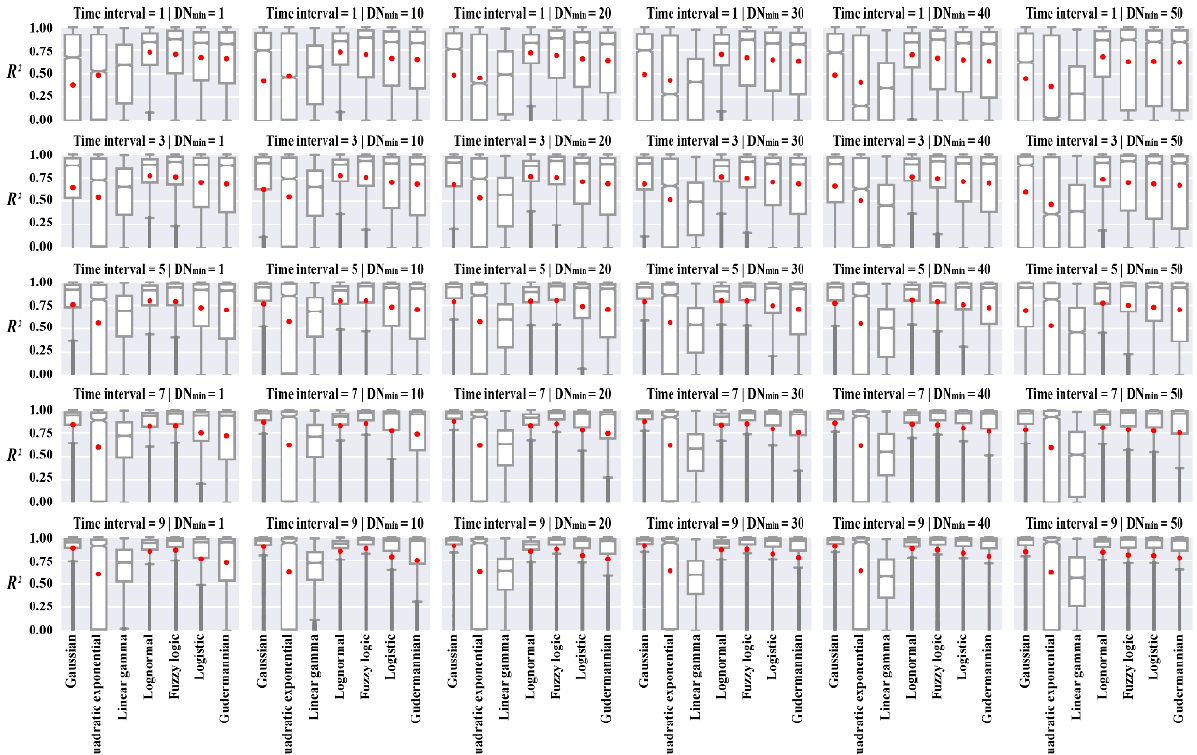
Figure 8. Goodness of fit ( R 2 ) of different bell-like functions when fitting the empirical waves of variations in human activity intensity observed during 1992 and 2018, with the lower limit of DN values varying from 1 to 50 (with an increase of 10) and the time interval varying from 1 year to 9 years (with an increase of 2 years). The red point indicates the mean value of R 2 . Note that if a function fails in fitting an empirical wave, then it was excluded from the boxplot. Figure 9 details the R 2 values of the Gaussian model when simulating variations in the intensity of urban-related human activities with the lower limit of DN values set to 30 ( DN min = 30) and the time interval set to 5 years ( ∆ t = 5). The average R 2 is 0.79, with standard deviation of 0.36, for all the fitted Gaussian models (#5148) for urban-related human activity. Nearly 76.76% of these fitted models have R 2 values higher than 0.8, 81.64% have R 2 values higher than 0.7, and only 13.81% have R 2 values lower than 0.5. Nearly half of the sample cities have an average R 2 higher than 0.8, and only 5 cities have an average R 2 lower than 0.5. The maximum and minimum mean R 2 is 0.98 (city of Laibin) and 0.22 (city of Jincheng), respectively, among the sample cities. For the 22 time periods (using the rolling strategy), more than half show average R 2 larger than 0.8, with a maximum of 0.94, and only 1 time period (2013–2018) shows an average R 2 lower than 0.5. The average R 2 values tended to decline slightly as time passed, but the city size (indicated by urban population) seems to impose only moderate impact on model